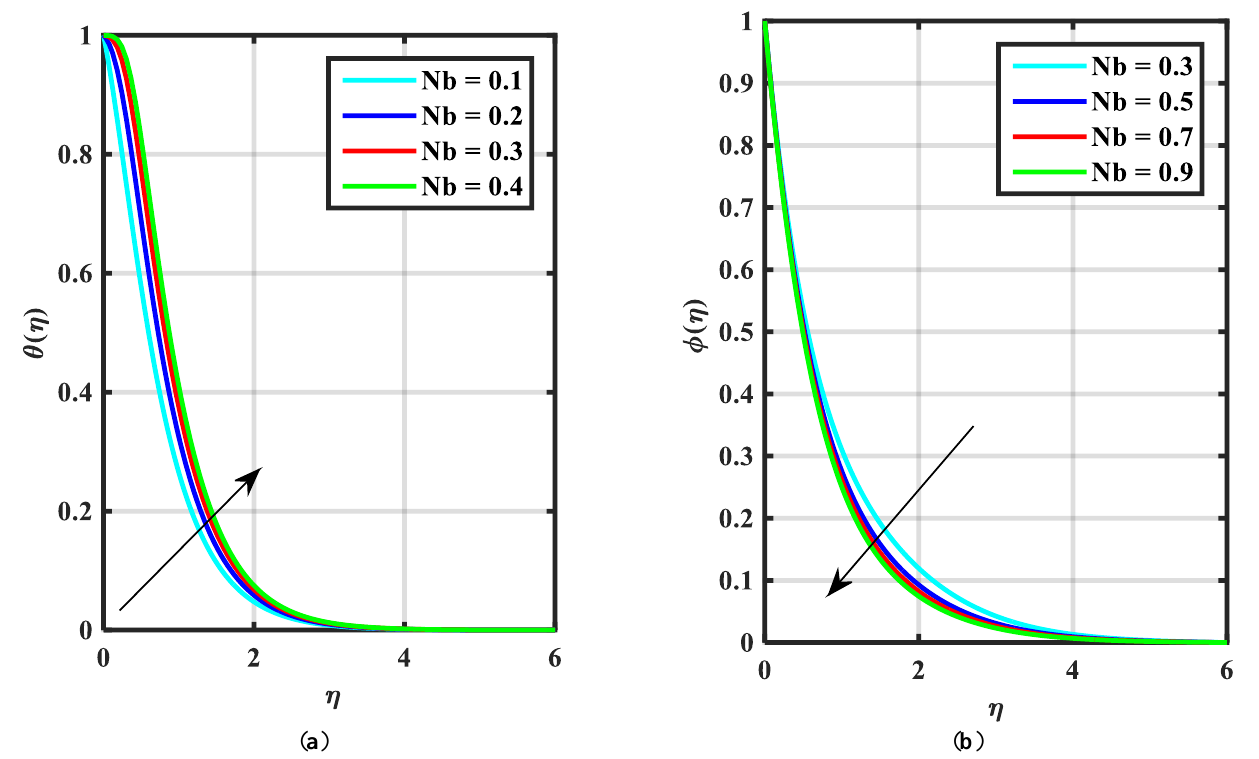
Figure 7. ( a , b ) Influence of 𝜃(𝜂) , 𝜙(𝜂) temperature over Brownian parameter 𝑁𝑏 .